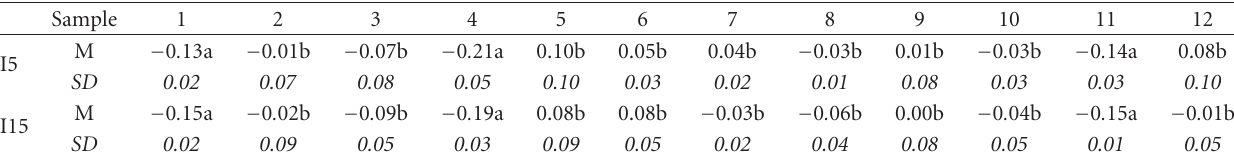
Table 3: Toxicity index of the water extract at 5 min (I5) and 15 min (I15). (M: mean; SD: standard deviation; a, b: significant di ff erences ( P < . 05) in Tukey